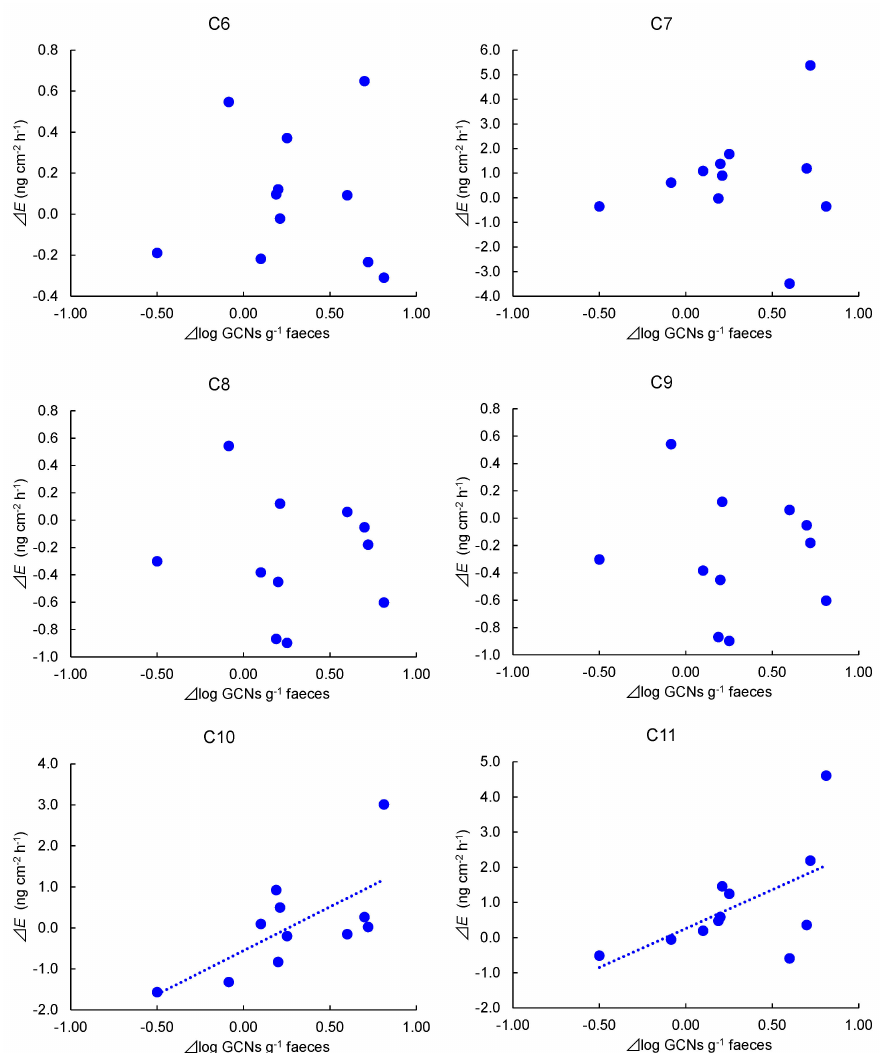
Figure 5. Scatter plots of the 16S rRNA gene copy numbers of bifidobacteria in faeces and dermal emission fluxes of γ -lactones in all 10 healthy participants (original 6 plus additional 4 participants). X-axis: changes in log GCNs g − 1 from Day 2 to Day 17; Y-axis: changes in the dermal emissions from Day 2 to Day